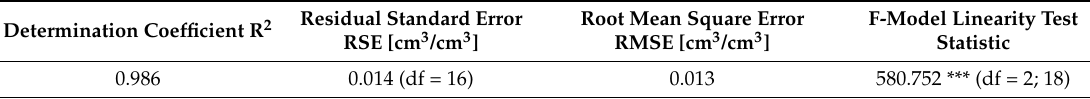
Table 2. Statistical parameters of the developed calibration model of the surface TDR probe.